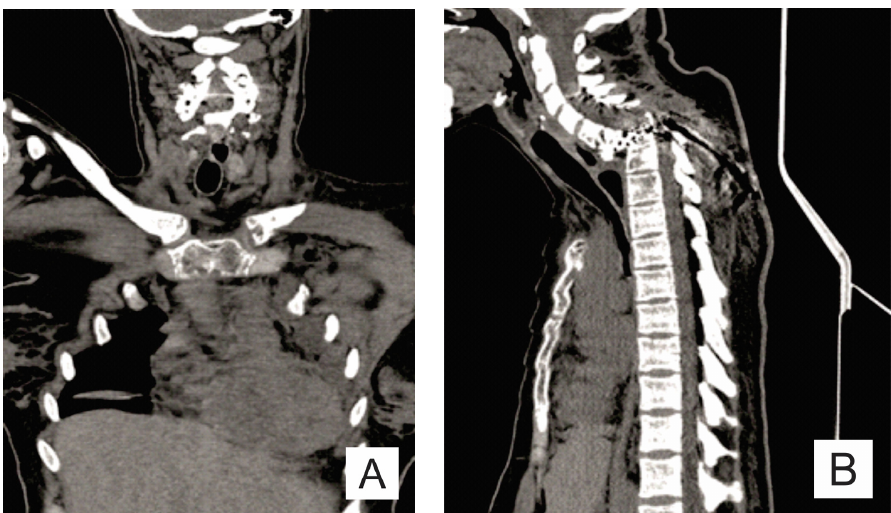
Figure 3. ( A ) Coronal CT scan: almost complete osteolysis of the left clavicle with absence of acromial end; and ( B ) sagittal CT scan: cervical spine dislocation with maximum angulation angle at the C6–C7 level, spinal cord compression at this level, and bone lysis in the C6 and C7 bodies .